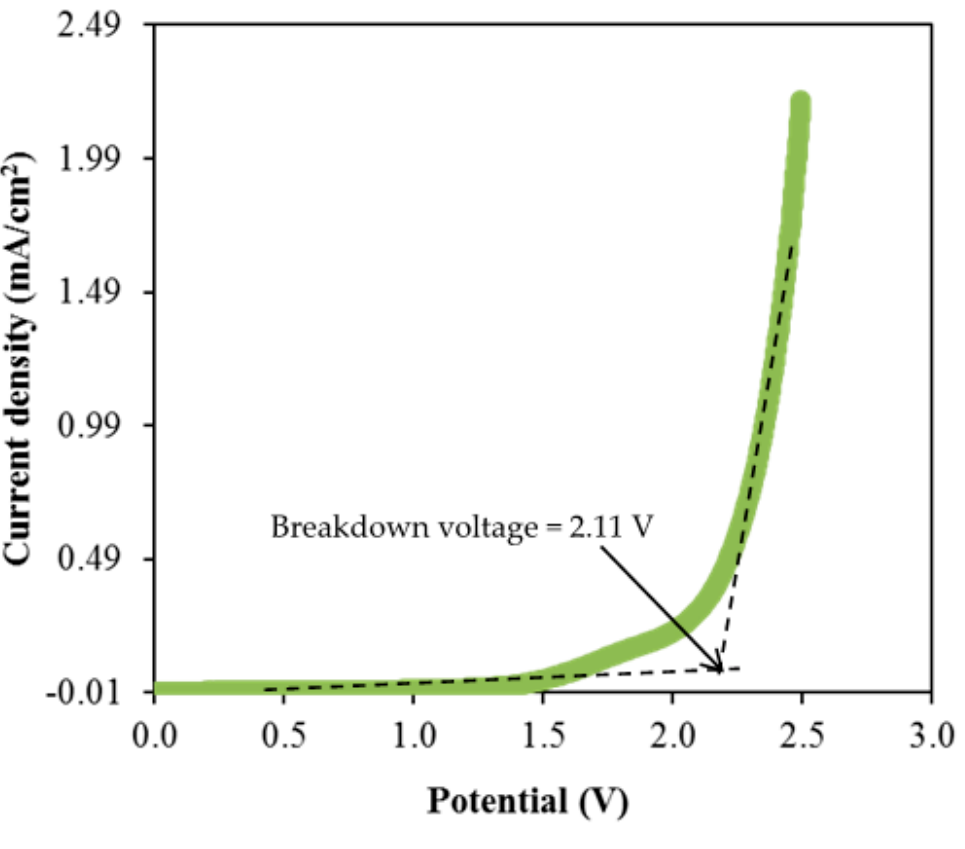
Figure 8. LSV plot of CSMCD3 electrolyte at room temperature.